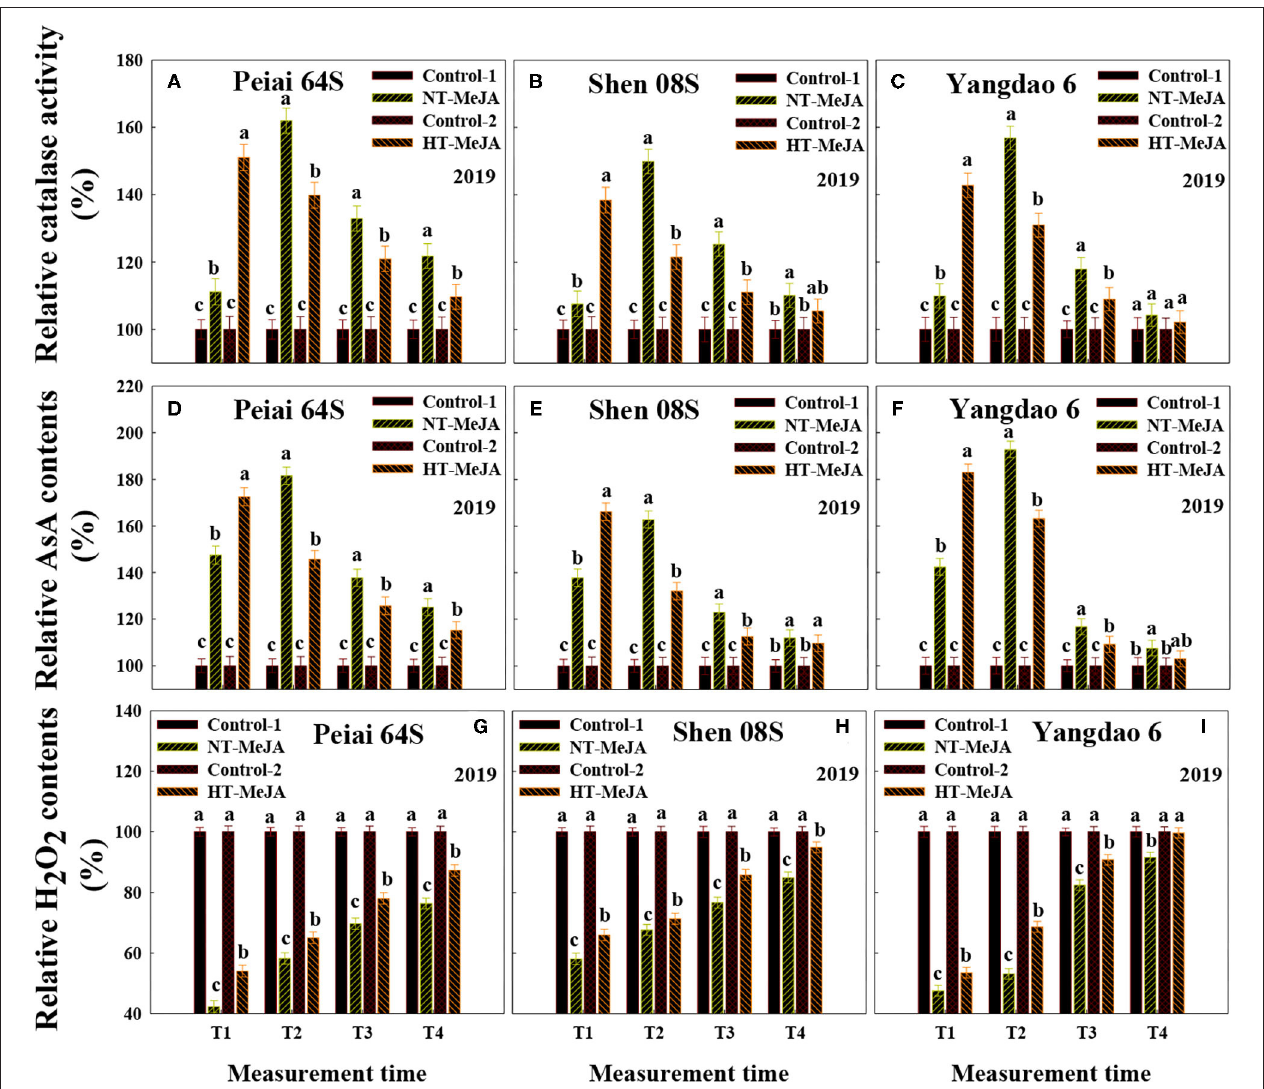
FIGURE 4 | Effect of MeJA application on the catalase activity (A–C) and the contents of ascorbic acid (AsA) (D–F) and H 2 O 2 (G–I) in stigmas of rice subjected to high-temperature stress during anthesis. Control-1 and Control-2 indicate spraying water under normal temperature (NT) and spraying water under high temperature (HT), respectively. NT + MeJA and HT + MeJA represent spraying MeJA under NT and spraying MeJA under HT, respectively. Data are expressed as relative values, and those of controls are taken as 100%. T1: 12:00h on the first day during the temperature treatment; T2: 14:00h on the first day during the temperature treatment; T3: 14:00h on the second day during the temperature treatment; T4: 14:00h on the first day after the temperature treatment. The bars are SD of three biological replications. Different letters above the bars represent significant differences at the P ≤ 0.05 level within the same line and the same measurement